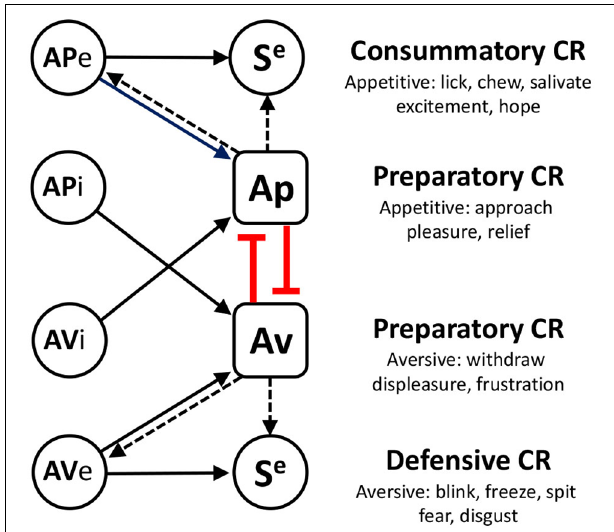
FIGURE 1 | A summary of Konorski’s theory of Pavlovian incentive learning. Appetitive (APe) and aversive (AVe) excitors activate sensory specific (S e ) and affectively specific (Ap or Av) components of the US representation to generate consummatory (defensive) or preparatory conditioned responses (CR), respectively. At the heart of this position is an opponency between appetitive and aversive affective systems which are assumed mutually to inhibit one another. One consequence of this view is that it provides a principled account of conditioned inhibition. Thus, appetitive inhibitors (APi) are aversive and so activate the aversive system whereas aversive inhibitors (AVi) are appetitive and activate the appetitive system. As a consequence, inhibitors can influence their concomitant excitors via this mutual inhibitory process (shown in red), reducing preparatory CR’s directly, and consummatory (and defensive) CR’s indirectly by reducing affective activation (dashed